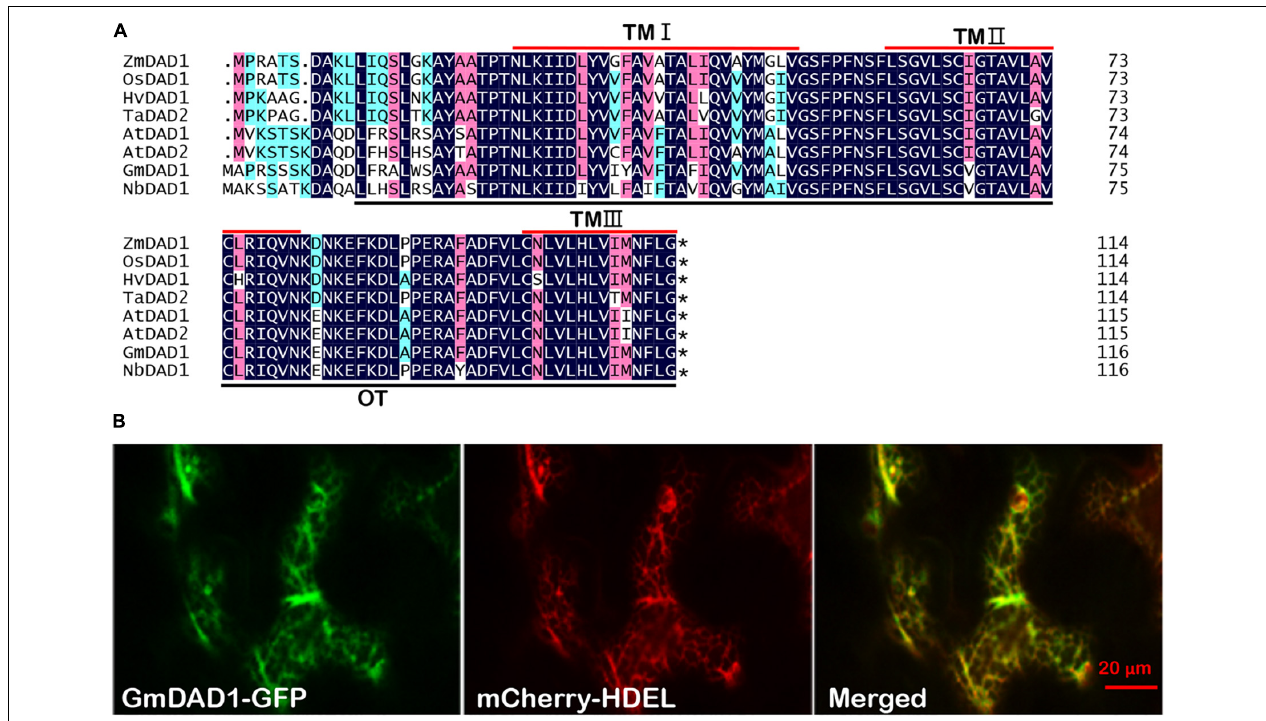
FIGURE 1 | Molecular characterization and subcellular localization of GmDAD1 protein. (A) Sequence alignment of GmDAD1 and other defender against cell death (DAD) proteins. The darkblue (100%), pink (75%), and cyan (50%) boxes represent levels of amino acid identity or similarity. TM, transmembrane domain; OT, oligosaccharyltransferase domain. At, Arabidopsis thaliana ; Hv, Hordeum vulgare ; Zm, Zea mays ; Os, Oryza sativa ; Ta, Triticum aestivum . The asterisk indicates the stop codon. (B) Subcellular localization of GmDAD1 was performed via transient expression system in Nicotiana benthamiana . Green and red fluorescence represent the signal of GFP fusion protein and ER marker mCherry-HDEL, respectively. The reticulate fluorescence pattern of GmDAD1-GFP and its co-localization with mCherry-HDEL indicate accumulation in the ER.